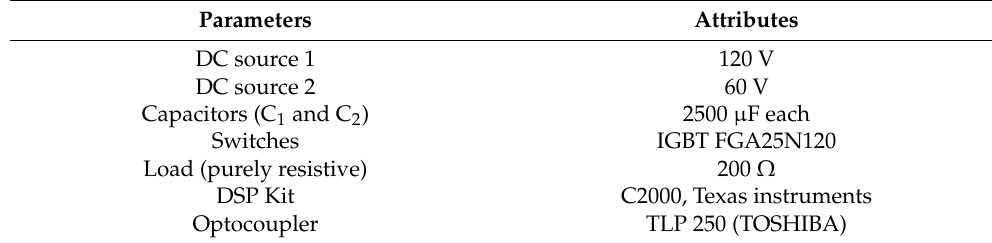
Table 5. Parameters of experimental validation.